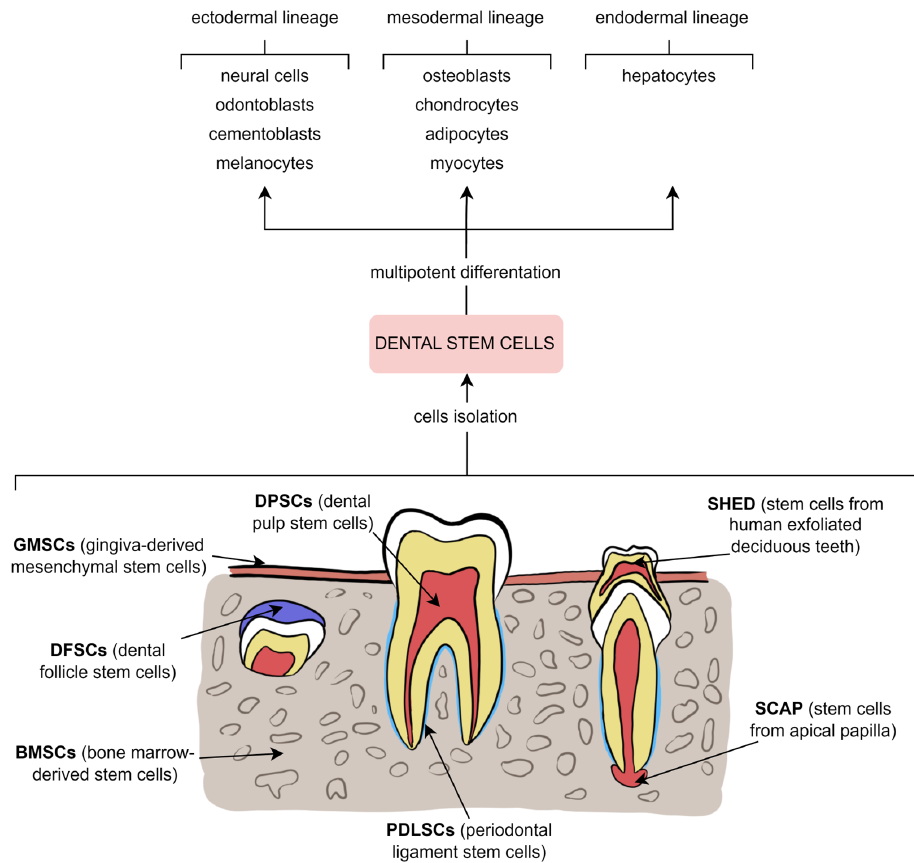
Figure 3. The dental stem cells – the origin and the differentiation.